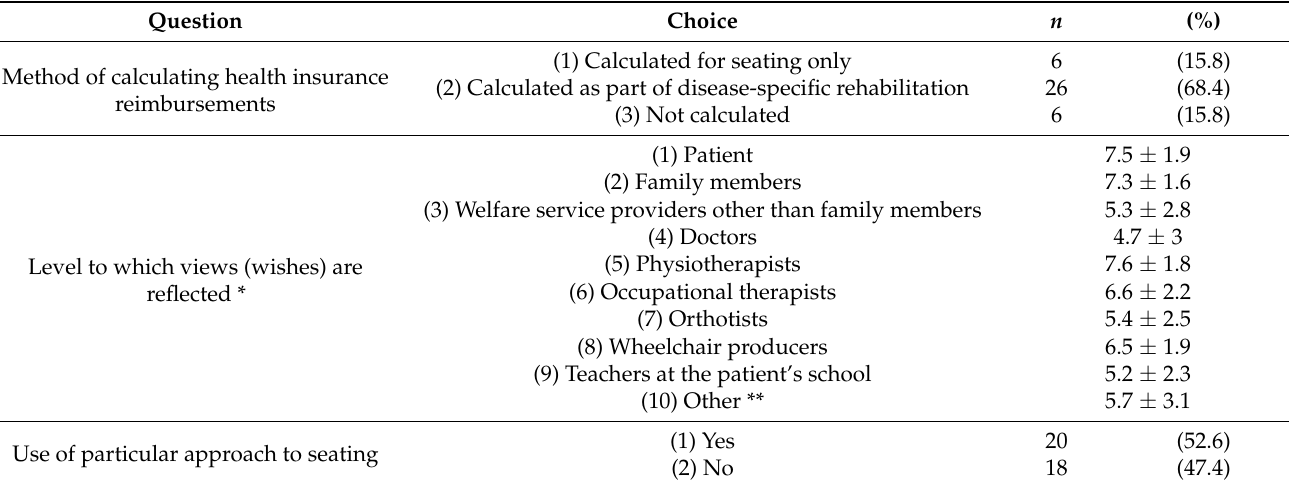
Table 4. Questions about procedures involved in seating ( n =